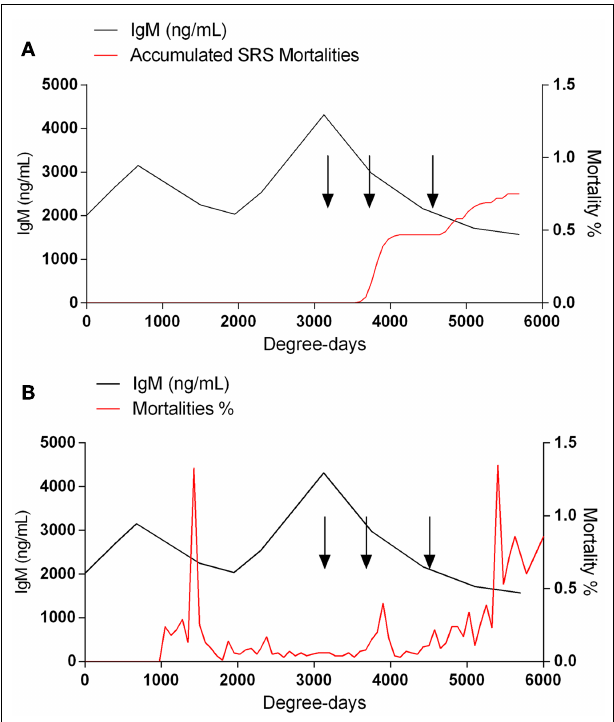
FIGURE 4 | A decreased IgM concentration is associated with an enhanced susceptibility to SRS infection . The IgM concentration and the mortality rate were monitored on daily basis during the productive cycle. Fish with SRS (A) or overall mortalities (B) was analyzed. SRS mortalities were diagnosed by PCR and symptomatology. The arrows at 3200, 3700, and 4600degree-days indicate florfenicol